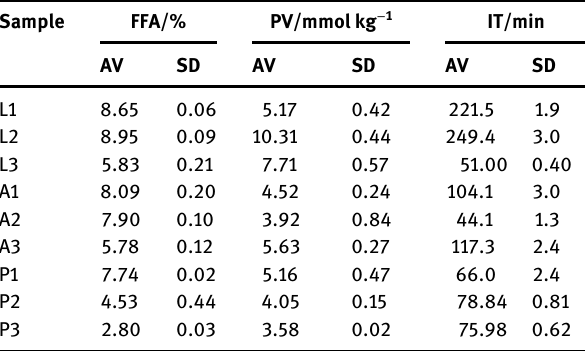
Table 1: FFA content, PV and IT averaged values followed by standard deviation ( SD ) determined for three samples from low - priced, fairly average priced and premium - priced cat feed. SD was rounded o ff to 1 or 2 s.f., and the main value was rounded to resulting from SD rounding number of decimal places Sample